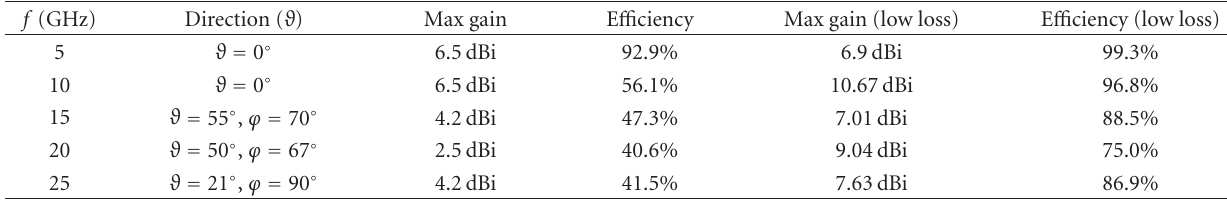
Table 2: Maximum gain if ports 1 and 2 are fed (Upper Element).